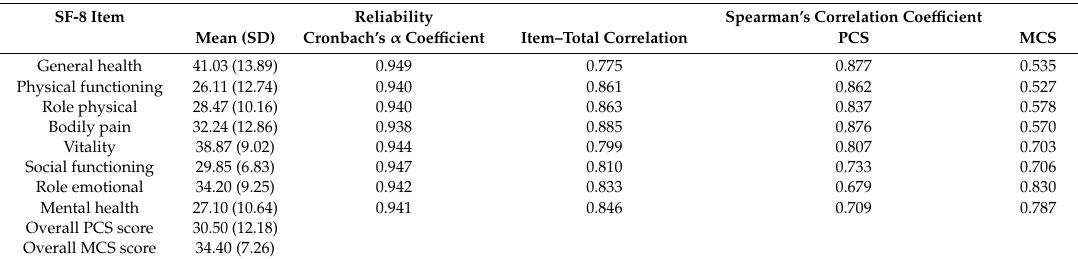
Table 1. Summary descriptive statistics, reliability, and correlation of the SF-8